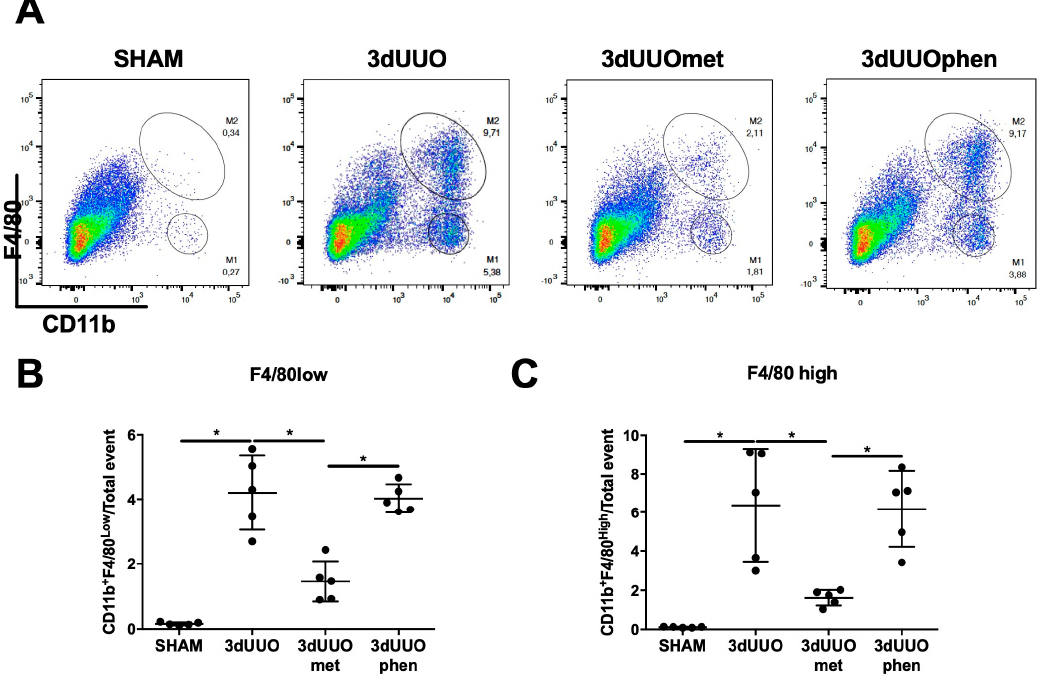
Figure 8. M1 and M2 cell infiltration into the UUO kidney is not a ff ected by phenformin. ( A ) Dot-plot of kidney cells separated by the cluster of di ff erentiation 11b (CD11b) and EGF-like module-containing mucin-like hormone receptor-like 1 (F4 / 80) expression, identifying M1 and M2 monocytes / macrophages. ( B , C ) Graphs of the proportions of M1 and M2 monocytes defined by F4 / 80 expression. n = 5 for each group. Each bar represents the mean ± SEM. * p <